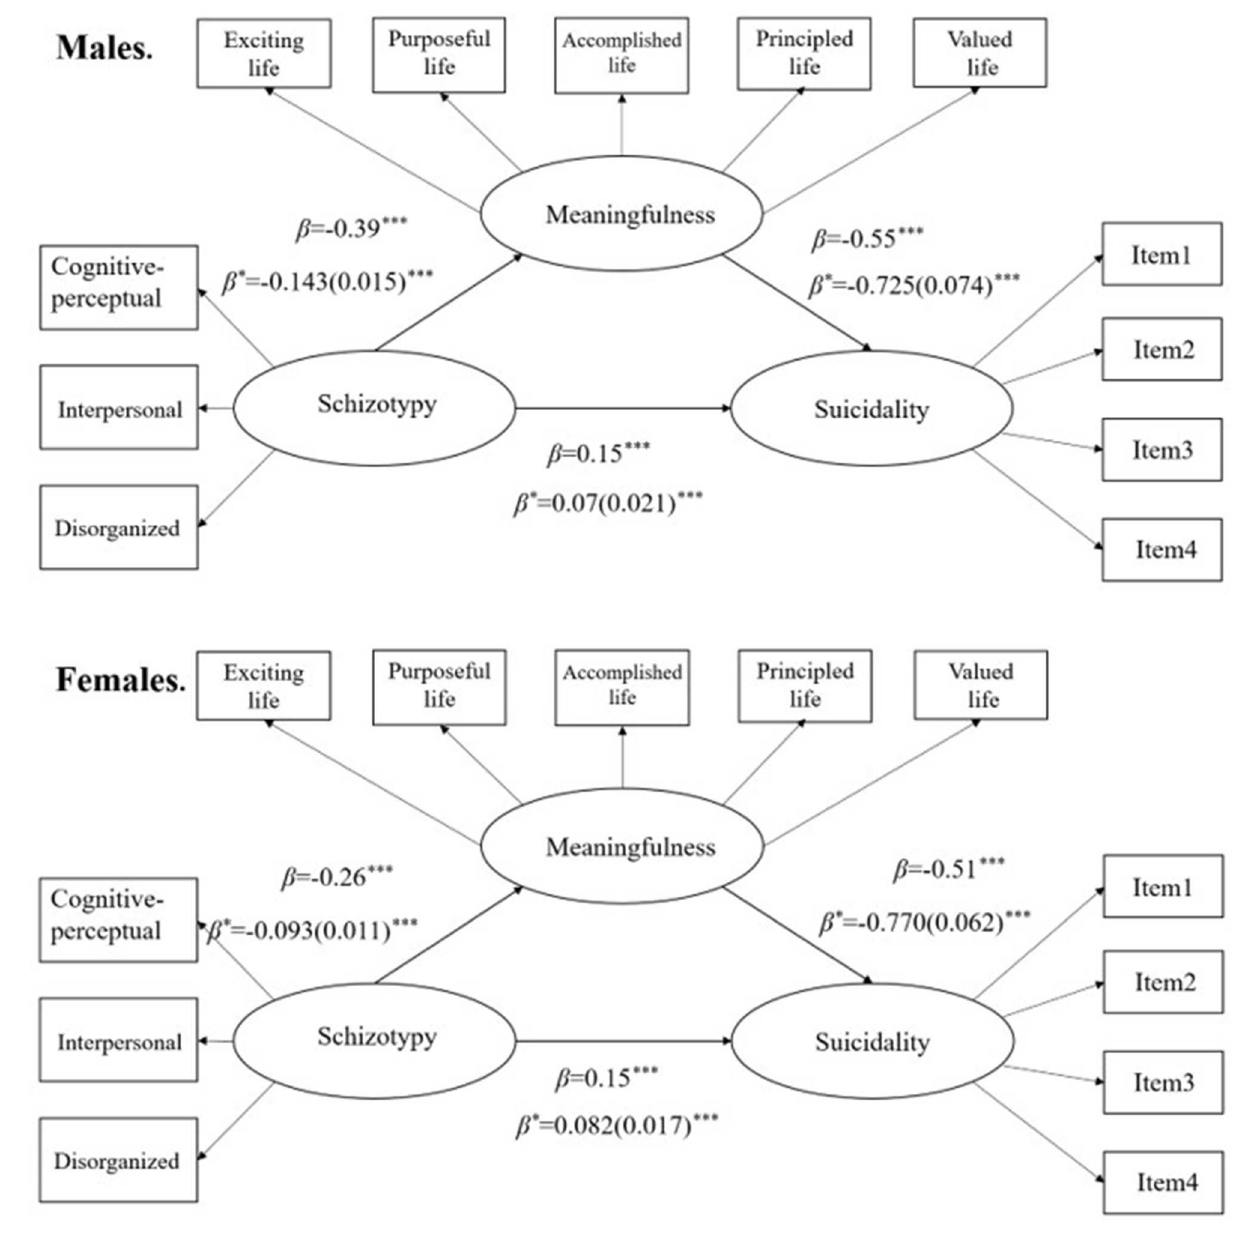
Frontiers in Psychology |